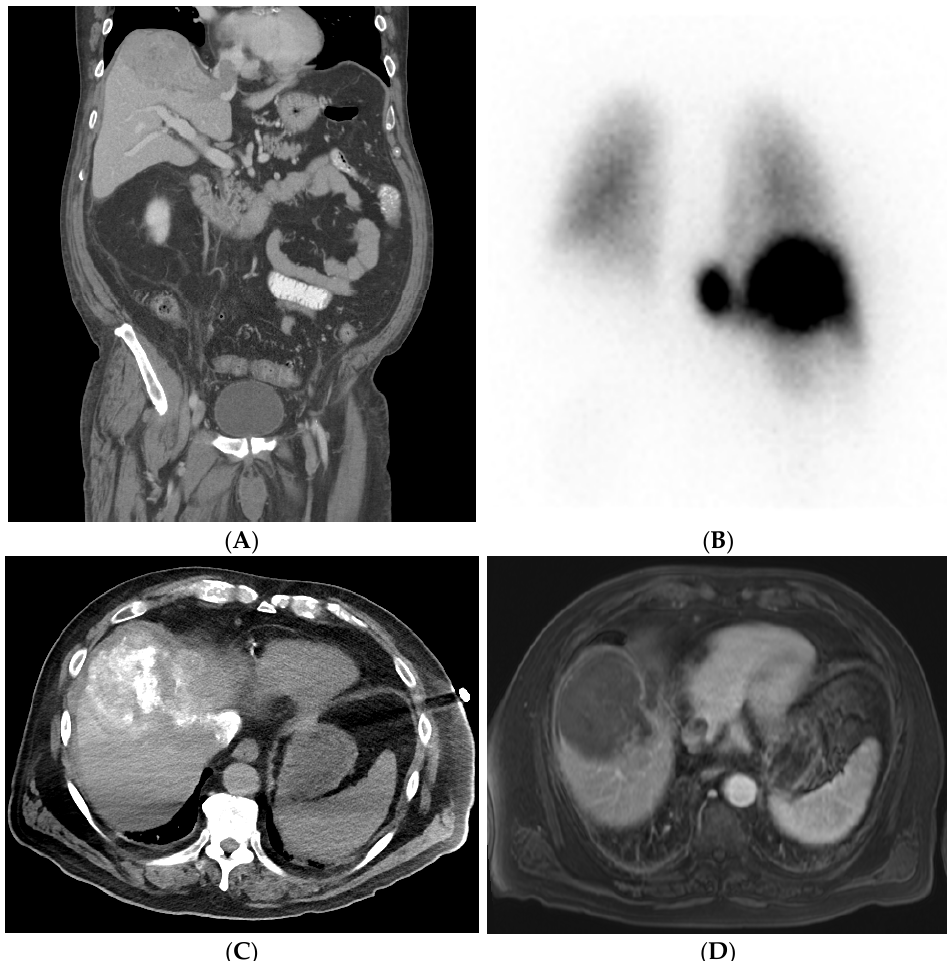
Figure 3. Patient with right lobe HCC with extension into the hepatic vein causing thrombosis. Pre-procedural investigation showed 30% shunt fraction, and therefore the patient was treated with cTACE. ( A ) Pre-procedural coronal CT shows right lobe HCC lesion with hepatic vein thrombosis. ( B ) A 99mTc-MAA SPECT/CT shows a lung shunt with a lung shunt fraction of 30%. ( C ) Intraoperative CT showing good lipiodol uptake in the treated lesion areas. ( D ) Follow-up MRI showing reduced non-enhancing HCC and hepatic vein thrombus due to good response after treatment.